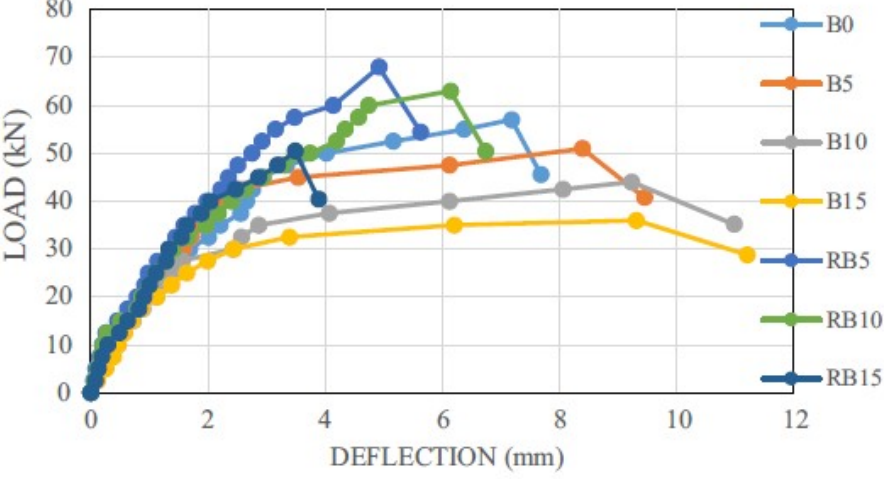
Figure 17. Load–deflection curves with ferrocement retrofitting scheme. Reproduced with permission Figure 17. Load–de fl ection curves with ferrocement retro fi tt ing scheme. Reproduced with per- from [44], Elsevier, 2016. Note: B and R represent control and retrofitted specimens with 0%, 5%, 10% mission from [44], Elsevier, 2016. Note: B and R represent control and retro fi tt ed specimens with and 15% corrosion 0%, 5%, 10% and 15% corrosion levels